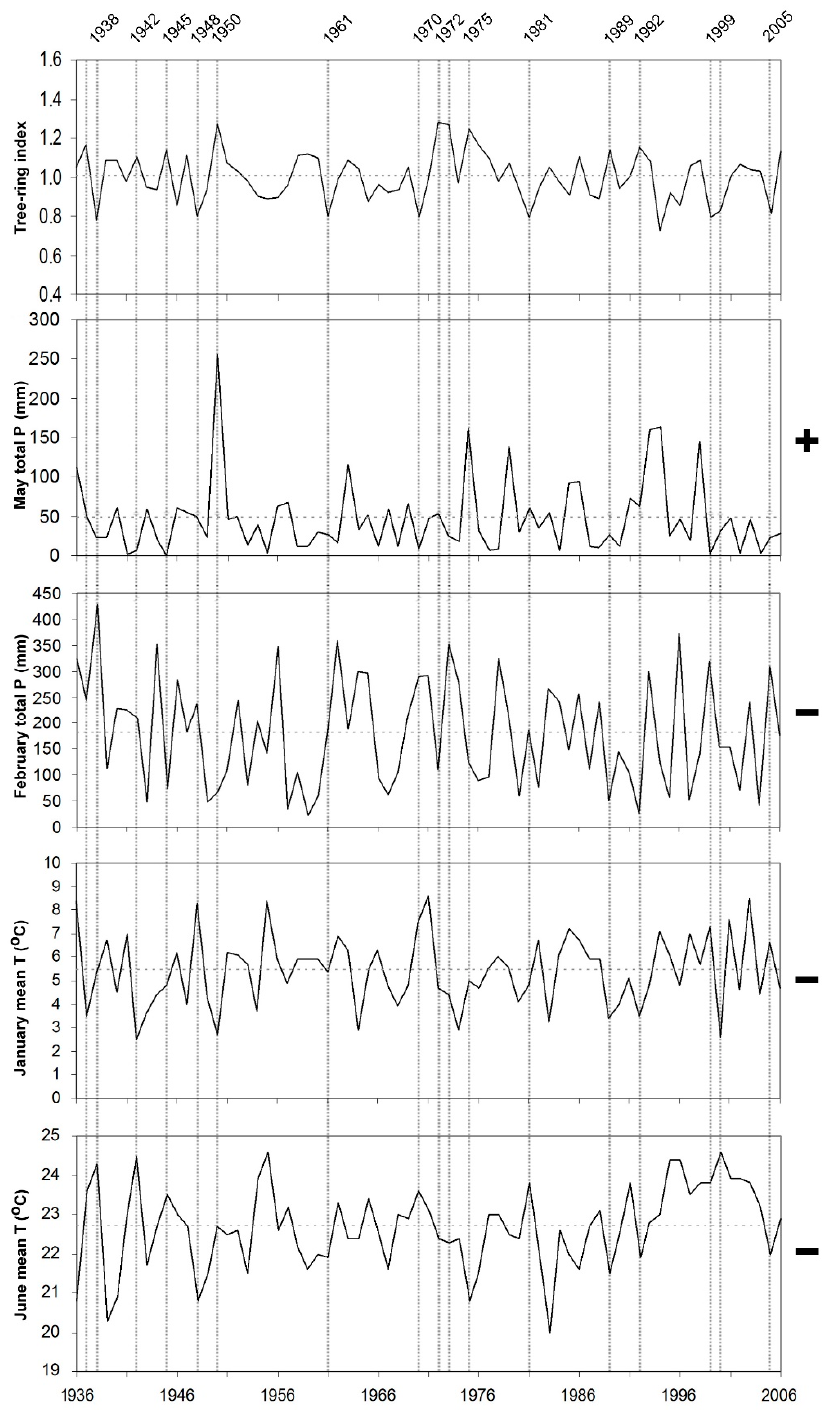
Figure 5. Residual chronology of upper limit of black pine on the south slope (AGU site), and limiting climate factors, which are May total precipitation, February total precipitation, January mean temperature and June mean temperature in the period of 1936–2006. Vertical dashed lines represent pointer years, which have very narrow and large ring formation years. Horizontal dashed lines represent the average value. “ + ” and “ − ” represent the positive and the negative correlation between climate factors and tree-ring width, respectively.